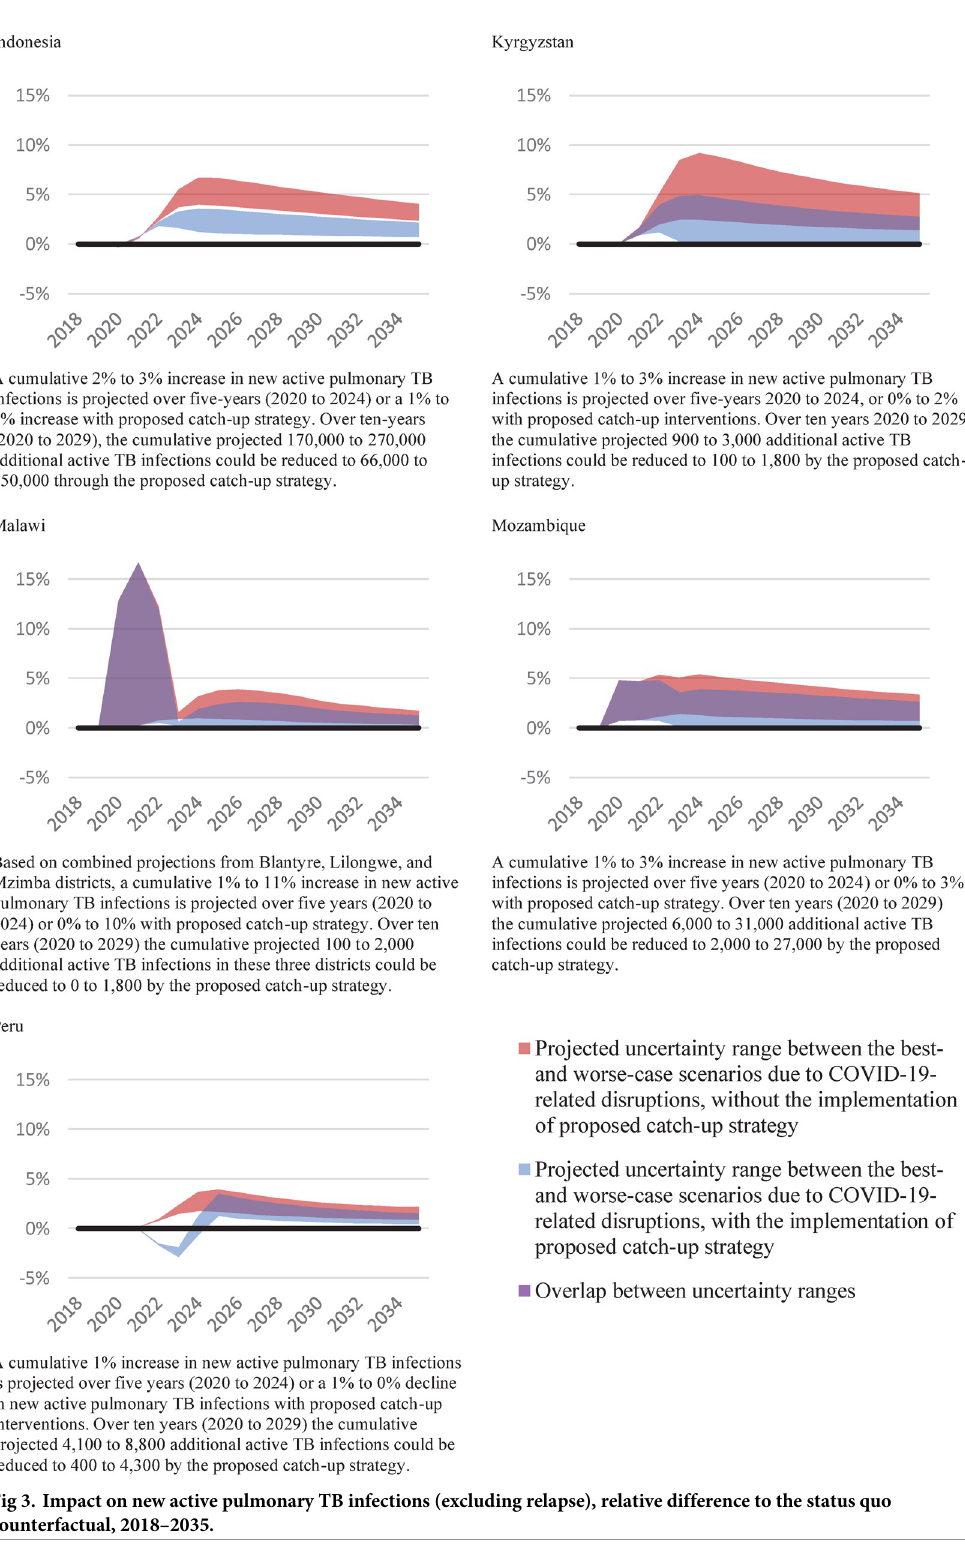
PLOS Global PublicHealth | https://doi.org/10.1371/journal.pgph.0000219 March 30,